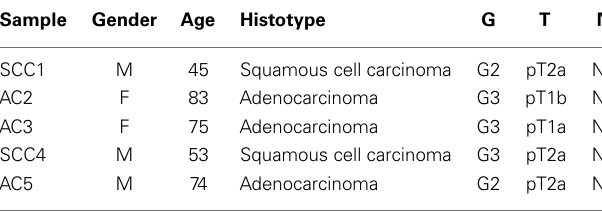
Table 1 | Clinicopathological characteristics of NSCLC studied ( n = 5)